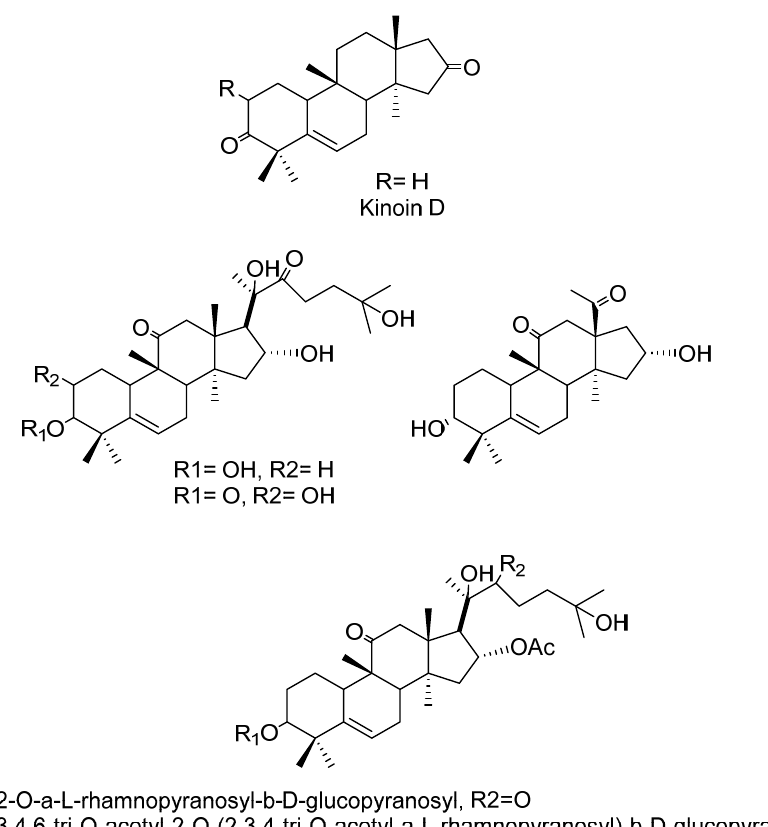
Figure 8. Kinoin D octanocucurbitacin-type triterpene with anti-inflammatory activity and other compounds isolated of I. sonorae .